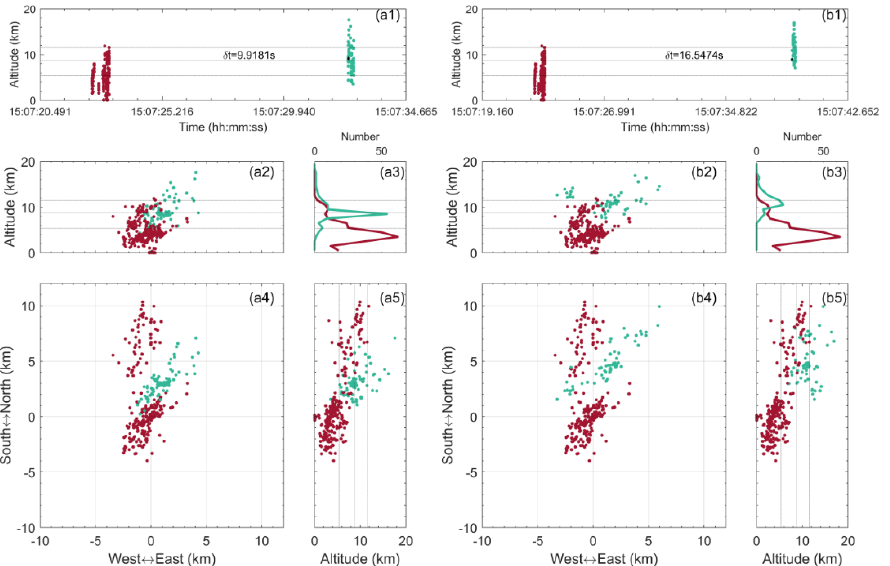
Figure 11. TLFs (in red color) and their corresponding NLFs (in green color) initiated within a 5 km radius of the flash-triggered position within 20 s after the TLFs. ( a ) and ( b ): TLF named T20170710150722 and its two corresponding NLFs, respectively. Subplot information is the same as in Figure 8.